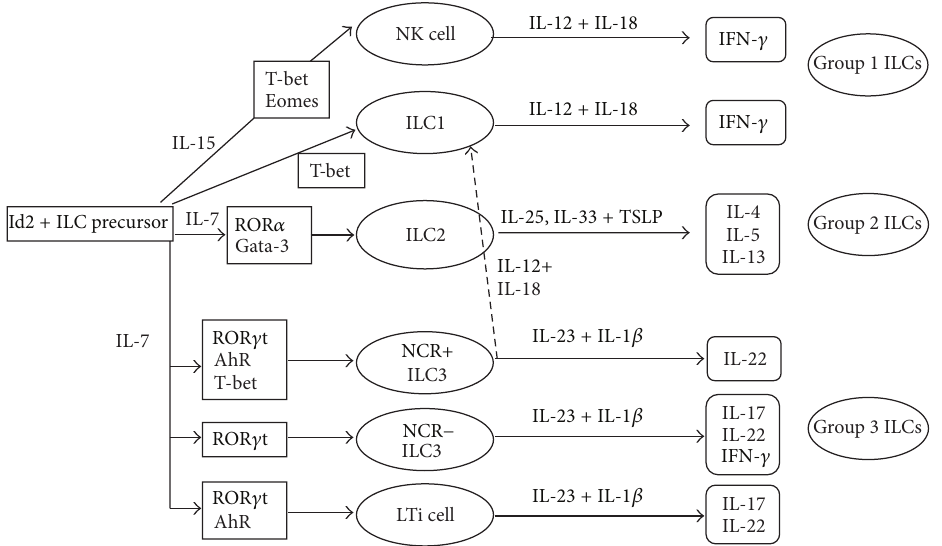
Figure 1: Schematic view of the differentiation of various innate lymphoid cells (ILCs), of the factors involved in such a differentiation, and of the cytokines produced by distinct subsets of ILCs. Id2, inhibitor of DNA binding-2; Gata-3, Gata-binding protein 3; ROR 𝛼 , retinoic acid receptor-related orphan receptor- 𝛼 ; Eomes, eomesodermin; NK, natural killer; LTi, lymphoid tissue-inducer; IL, interleukin; NCR, natural cytotoxicity triggering receptor; IFN- 𝛾 , interferon- 𝛾 ; AhR, aryl hydrocarbon receptor; TSLP, thymic stromal lymphopoietin.